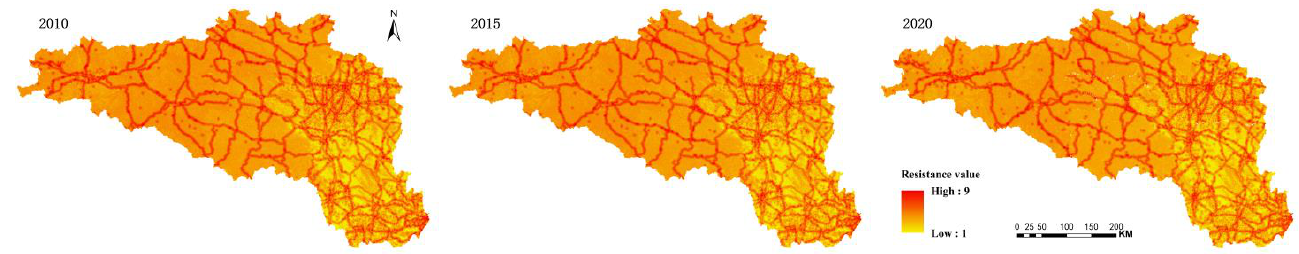
Figure 3. Comprehensive resistance surface.